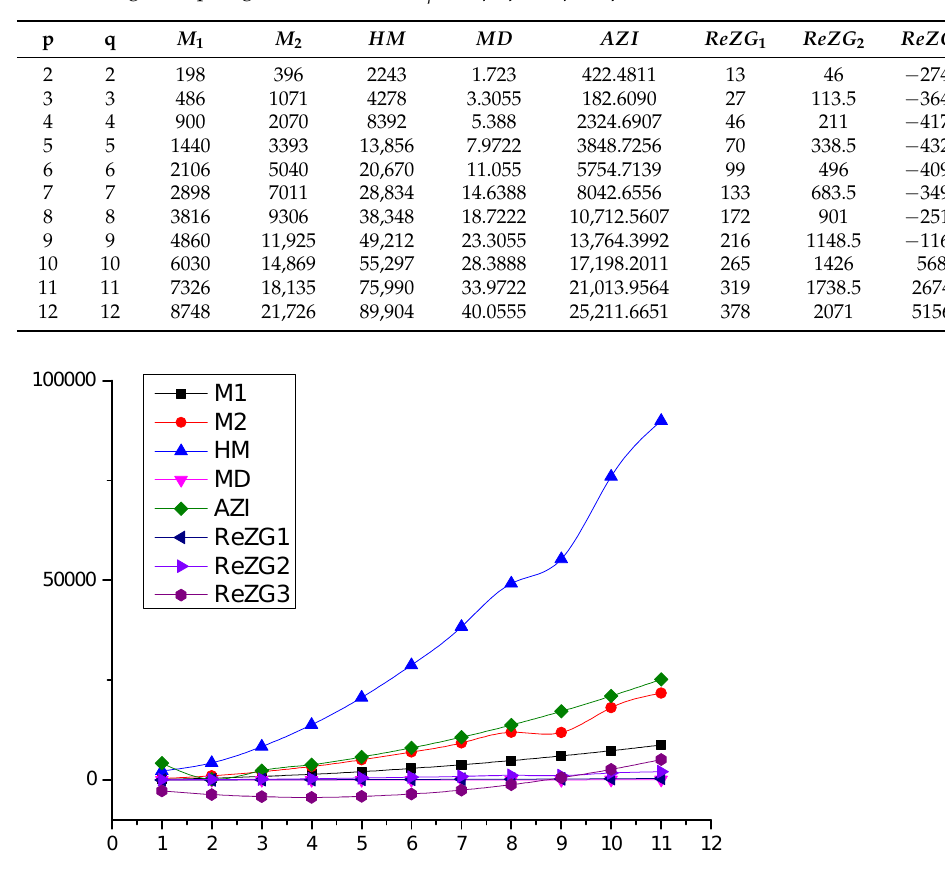
Table 2. Zagreb topological indices of SC p q , for p , q ≥ 2, p = q .